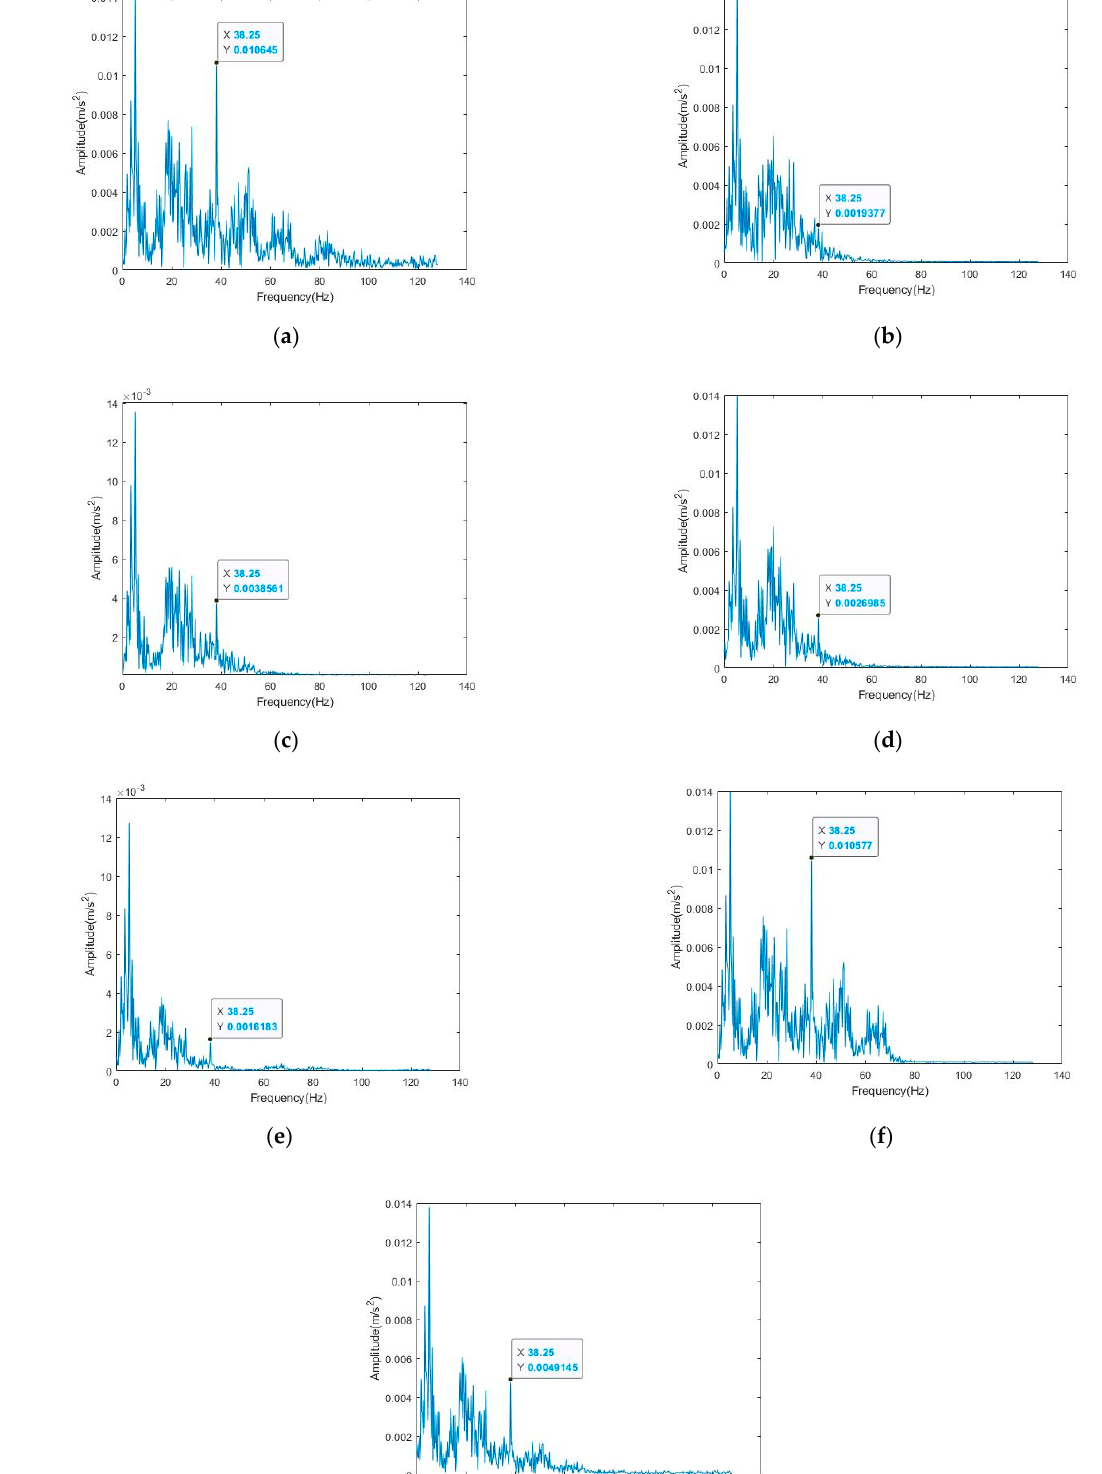
Figure 9. Frequency domain diagram of x -axis signal before and after denoising: ( a ) noisy signal; ( b ) EMD denoising method; ( c ) EEMD denoising method; ( d ) CEEMD denoising method; ( e ) bilateral filtering denoising method; ( f ) VMD denoising method; ( g ) CEEMD-BF denoising method.